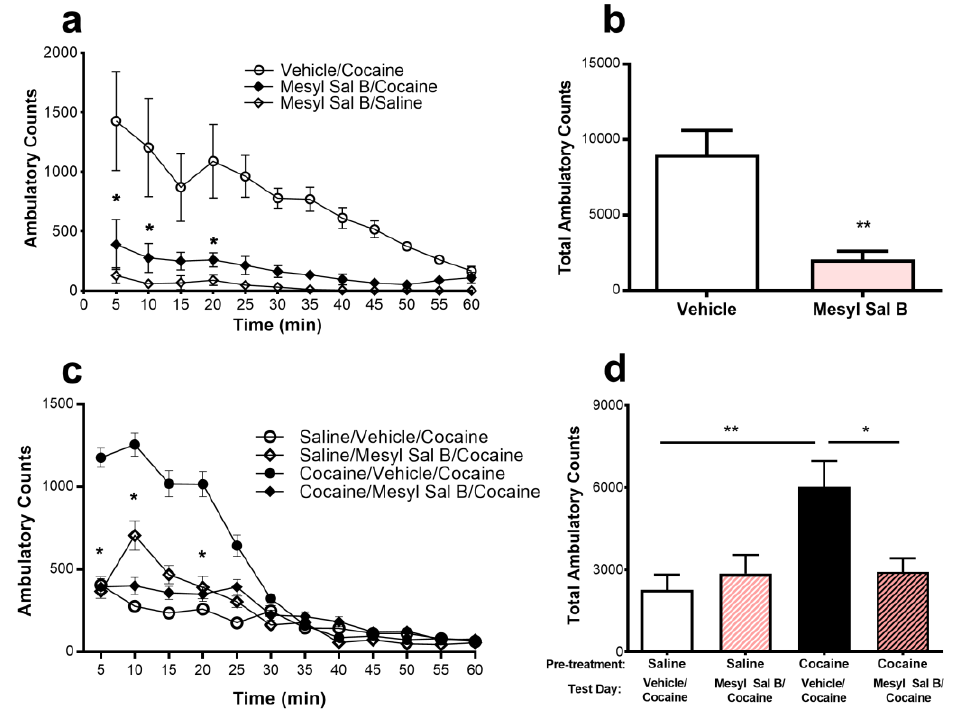
Figure 2. The effects of Mesyl Sal B on the expression of cocaine-induced hyperactivity and behavioral sensitization to cocaine were evaluated in rats. Pre-exposure to Mesyl Sal B (0.3 mg/kg, i.p.) 45 min prior to cocaine (20 mg/kg) significantly attenuated the cocaine-induced hyperactivity compared to vehicle-treated control rats: ( a ) Analysis of locomotor activity over time revealed significant effects of Mesyl Sal B administration on cocaine-induced hyperactivity at 5, 10, and 20 min. Two-way ANOVA followed by Bonferroni post hoc test. ( b ) Mesyl Sal B attenuated the total ambulatory counts observed in 60 min, Student t -test. ( c ) Rats were injected with saline (1 mL/kg) or cocaine (20 mg/kg) for 5 consecutive days then remained drug-free from days 6 – 9. On test day (day 10), rats were injected with either vehicle or Mesyl Sal B (0.3 mg/kg) and 45 min later they were injected with cocaine (20 mg/kg).